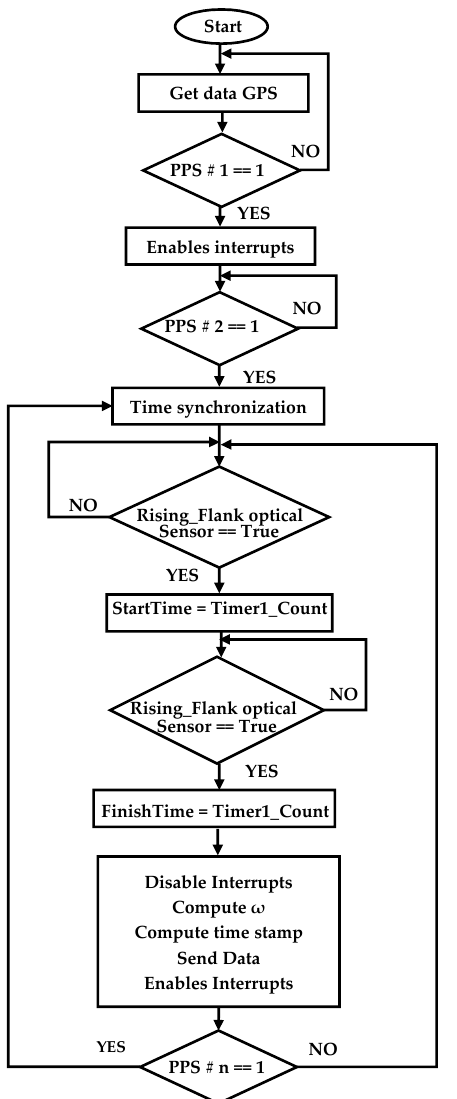
Figure 4. Flowchart of the algorithm to calculate the synchronized angular velocity.